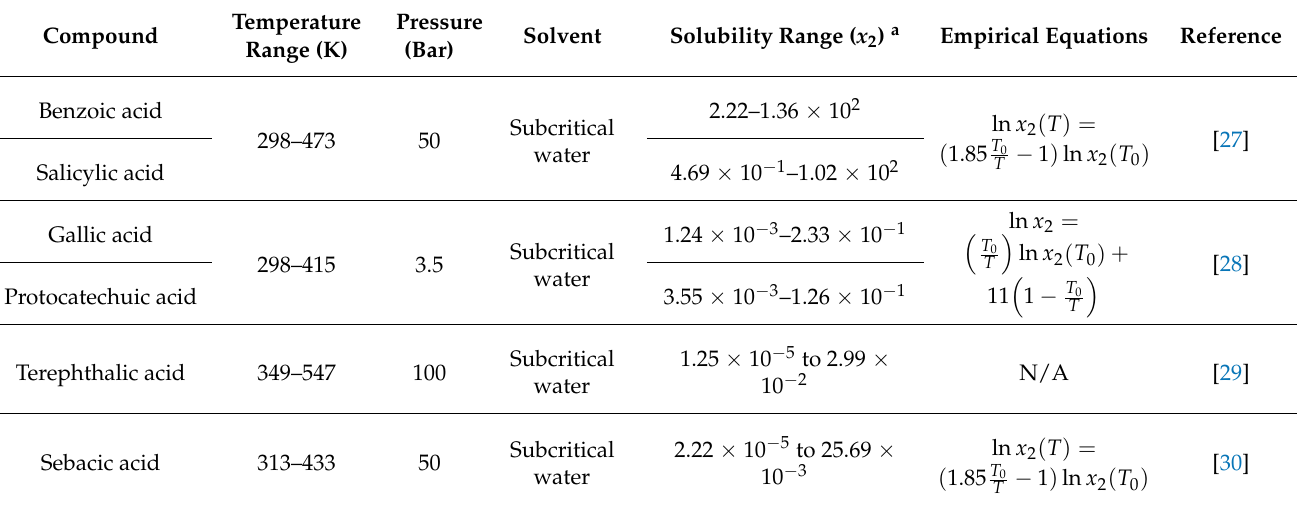
Table 3. Organic acid solubilities in subcritical